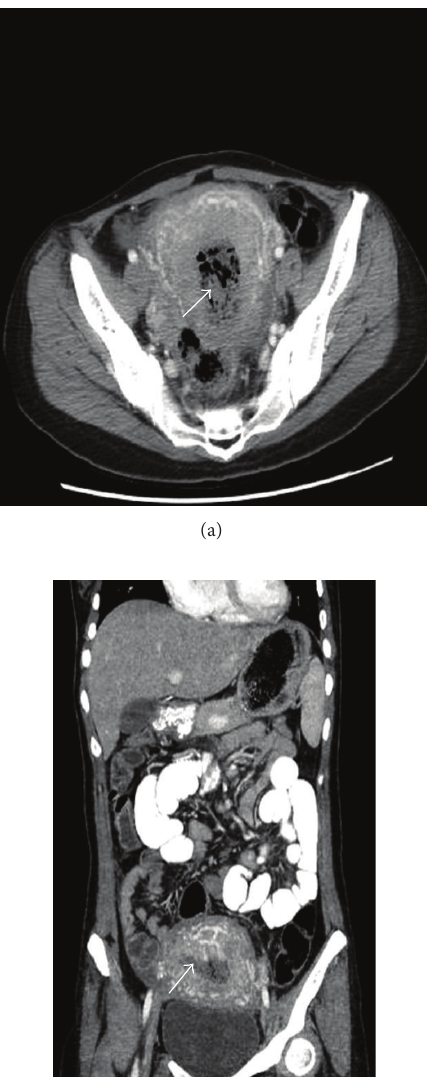
Figure 1: CT scan of abdomen and pelvis. Enlarged uterus with a markedly distended endometrial cavity contained a heterogeneous collection of soft tissue, debris, and gas bubbles